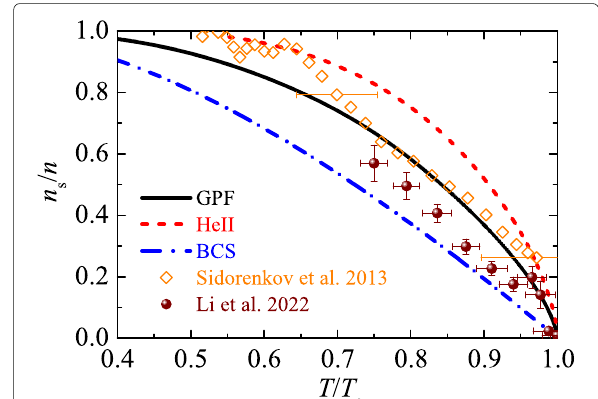
Fig. 20 The superfluid fraction of a unitary Fermi gas measured from the Insbruck experiment in 2013 [23] (empty diamonds) and from the USTC experiment in 2022 (solid circles) [33], as a function of the reduced temperature T / T c . The data are compared with the theoretical predictions from the Gaussian pair fluctuation (GPF) theory (black solid line) [14, 19] and mean-field BCS theory (blue dot-dashed line). The superfluid fraction of superfluid helium is also shown by a red dashed line